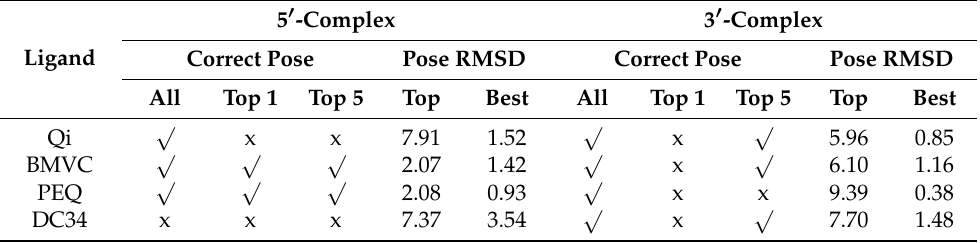
Table 4. Results obtained using